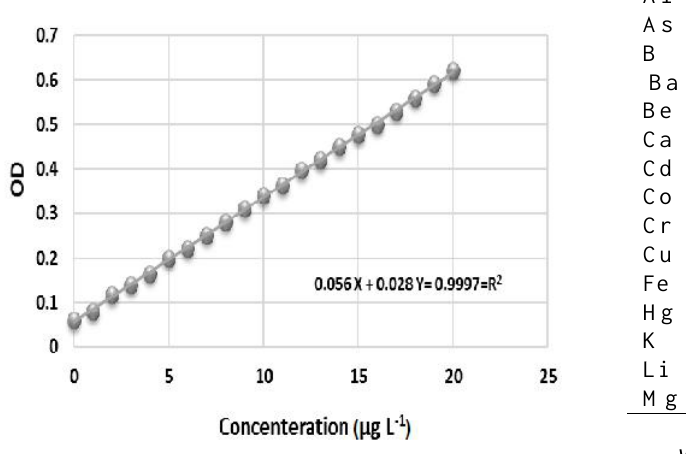
Fig. 2. Absorption rate of arsenic concentrations against chloroform based on the SDDC method